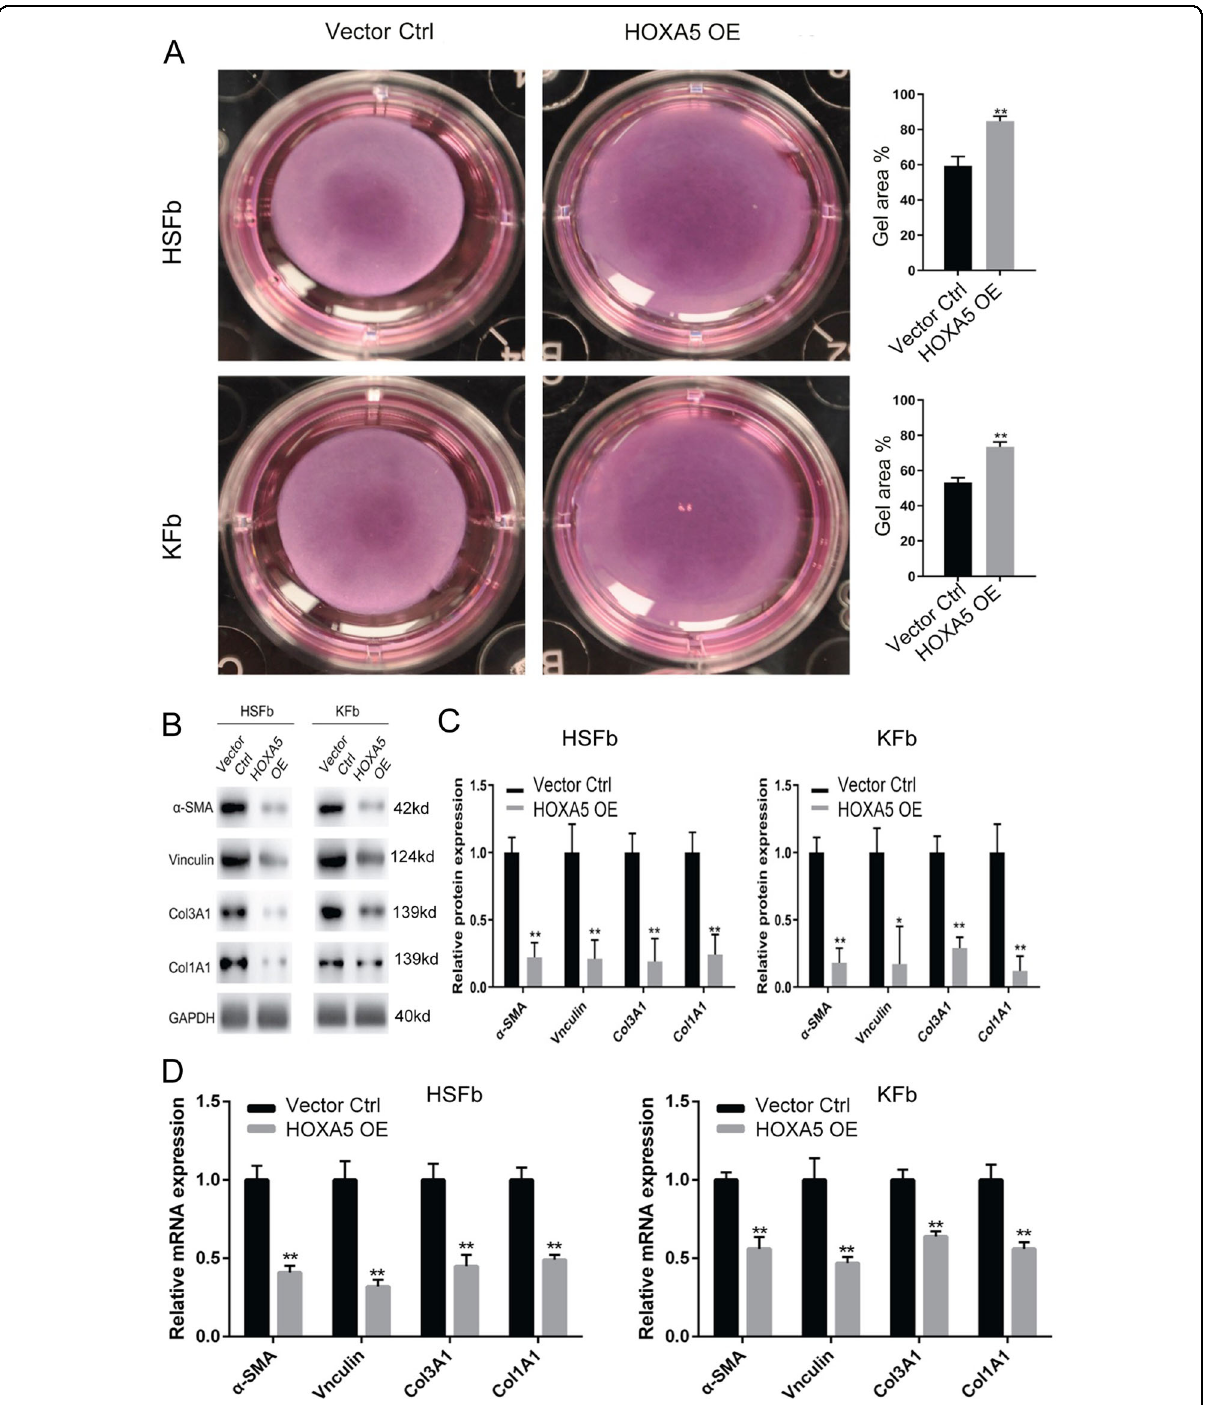
Fig. 2 Role of HOXA5 in pathological scar-derived fi broblasts. A A fi broblast-populated collagen lattice was used to measure the contractive abilities of KFb and HSFb in each group. B – D The expression of fi broproliferative biomarkers, including α -SMA, Vinculin, ColI, and Col III in KFb and HSFb in each group was detected by western blot and qPCR analysis. * p < 0.05, ** p <